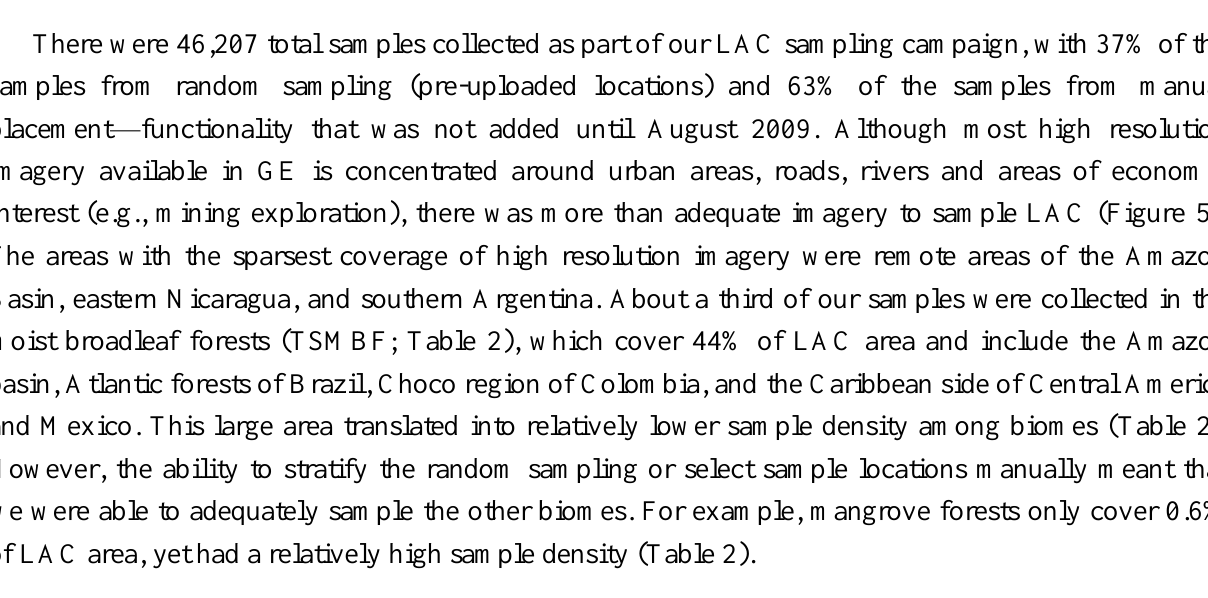
Figure 5. Sample density for Latin America and the